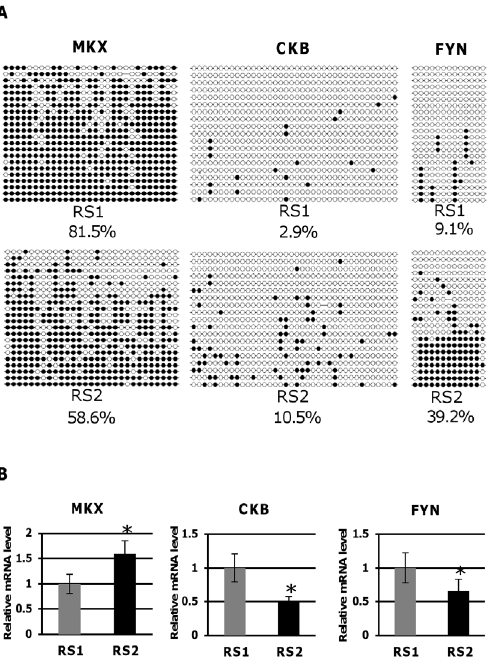
Figure 5. Validation of DNA methylation status and expression difference between the twins. (A) DNA methylation difference between the twins by bisulfite sequencing in the upstream regions of Mohawk Homeobox ( MKX ), Brain-type Creatine Kinase ( CKB ), and FYN Tyrosine Kinase Protooncogene ( FYN ) genes. The proportion (%) of methylated CpG sites is shown. (B) Expression difference between the twins. *p , 0.05.